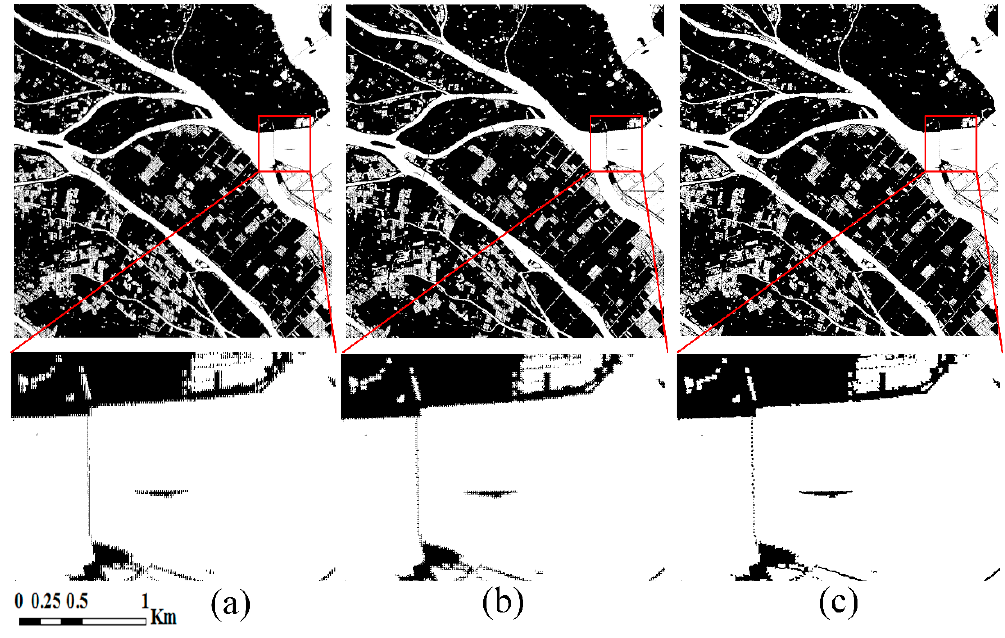
Figure 17. Subpixel water mapping results for Region E: ( a ) SPM L ; ( b ) SPSAM; and ( c ) MSWM.